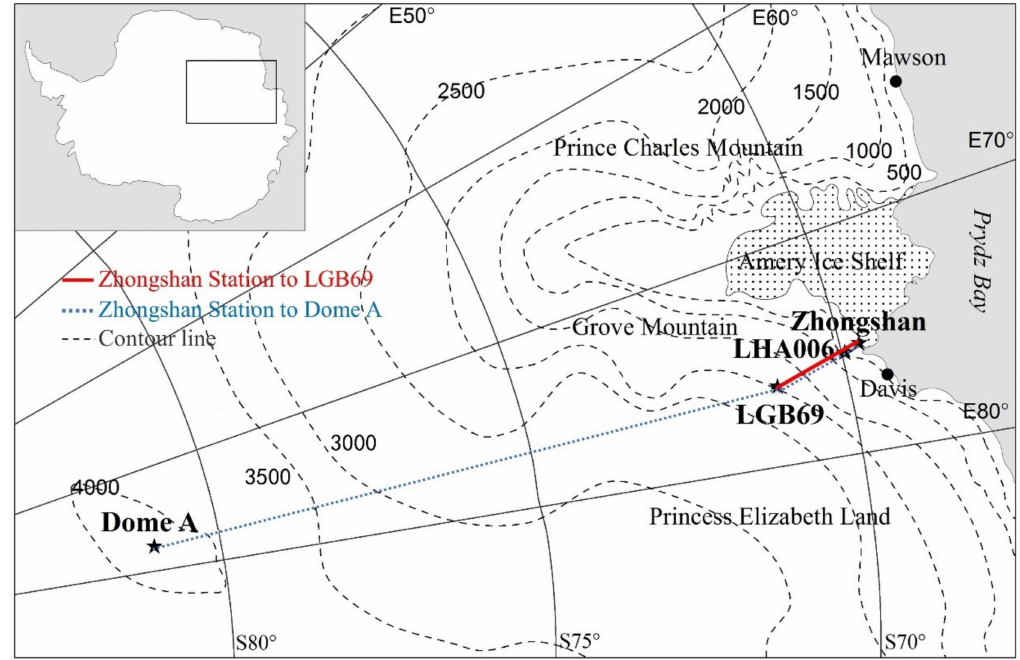
Figure 1. Sampling location. The red line indicates the transect from Zhongshan Station to LGB69 in this study; The blue dash indicates the entire transect from Zhongshan Station to Dome A; The black dash indicates contour